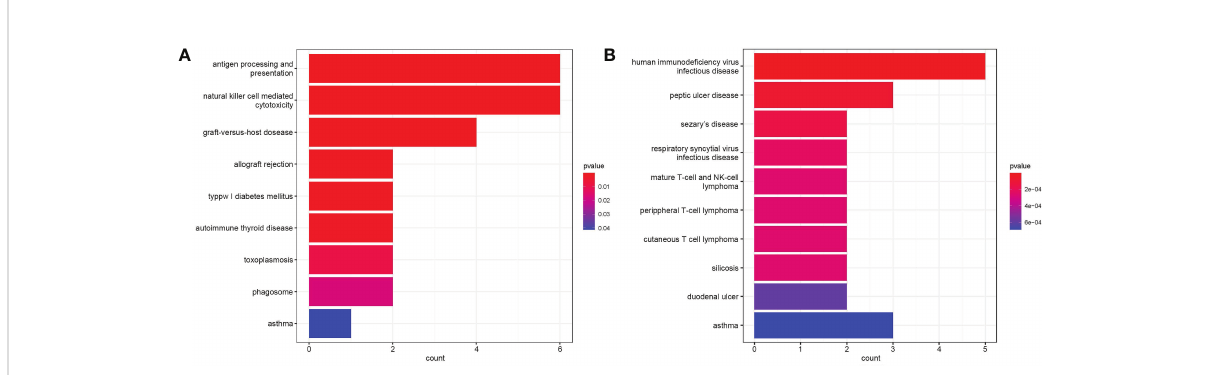
FIGURE 3 (A) Bar plot of results from Kyoto Encyclopedia of Genes and Genomes (KEGG) functional analysis indicating that antigen processing and presentation, natural killer cell mediated cytotoxicity, and graft-versus-host disease were most signi fi cantly activated in the gene sets ( P <0.05). (B) Bar plot of disease ontology (DO) functional analysis showed the top 10 diseases, with the immune differentially expressed genes (DEGs) primarily participating in the pathogenesis of human immunode fi ciency virus infectious disease ( P